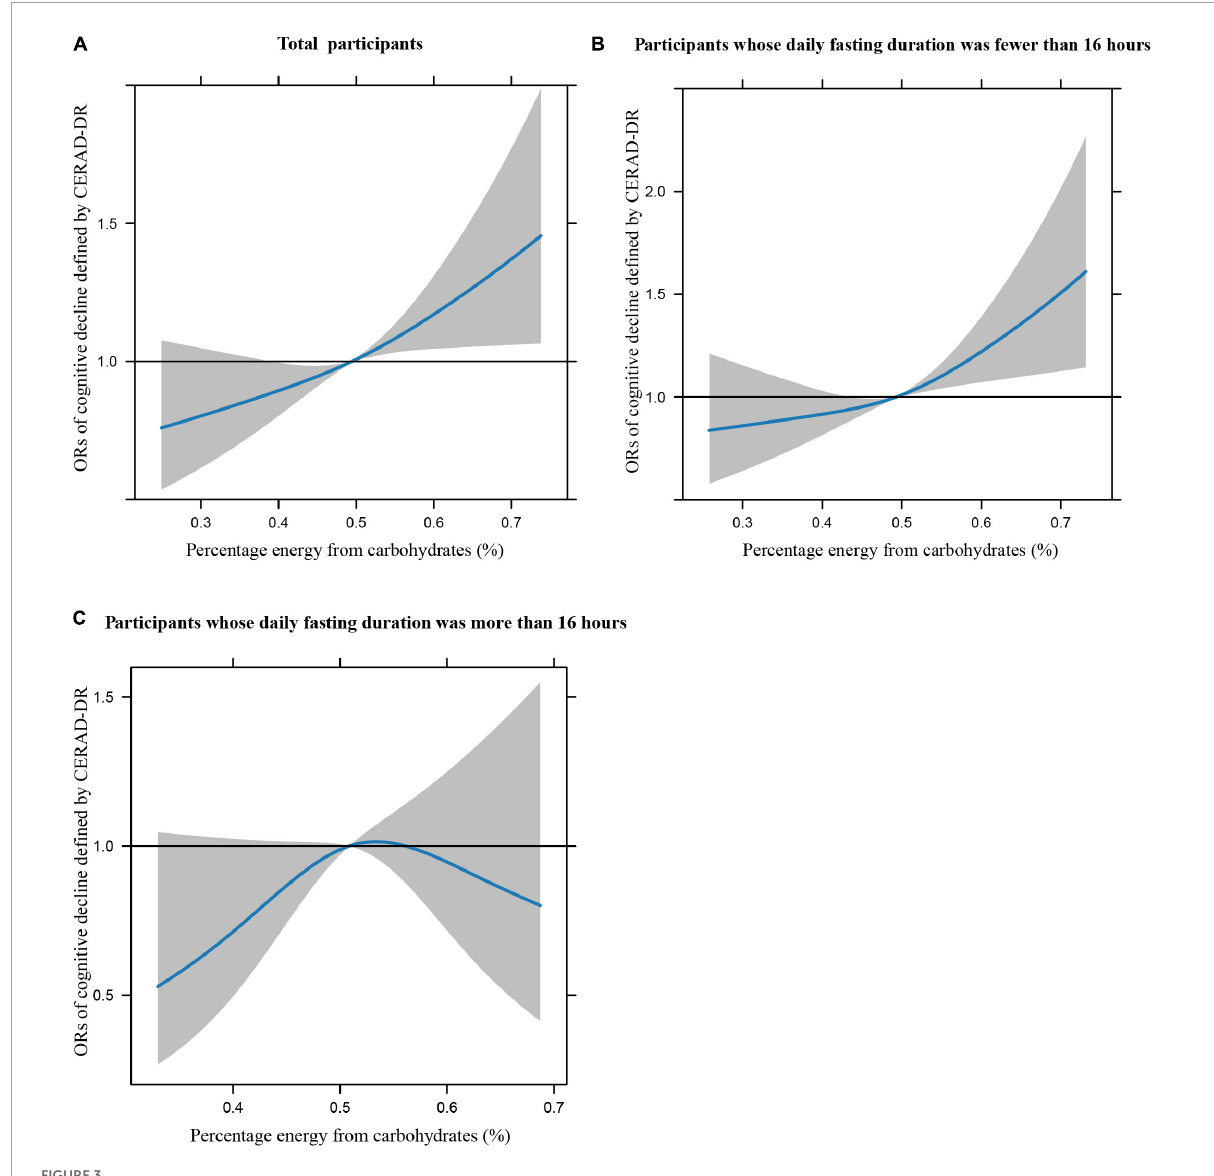
FIGURE3 Restricted cubic splines between percentage energy from carbohydrates (%) and poor cognitive performance of